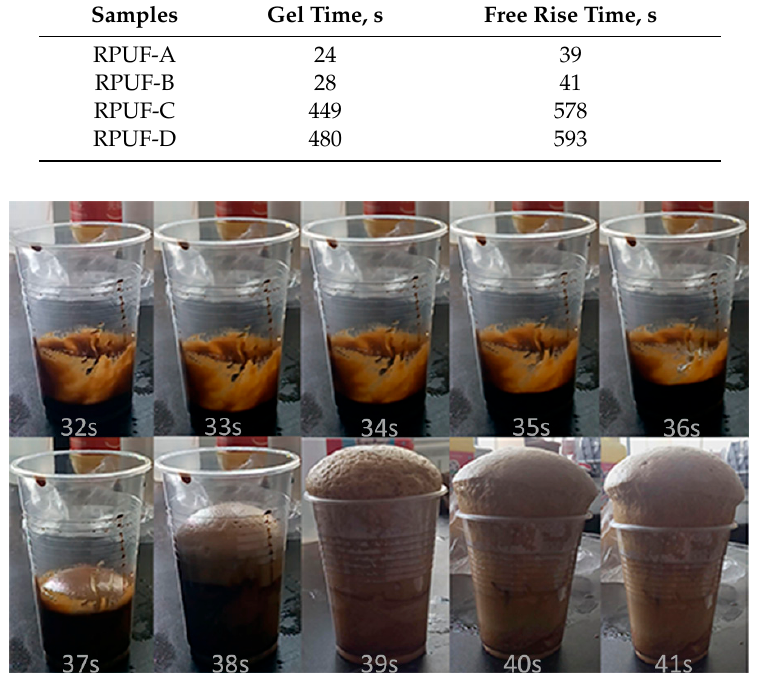
Figure 2. Foaming process of RPUF-B prepared from unfiltered bio-based polyols (BBPs) with neutralization by sodium hydroxide.